Question: Write a single sentence explaining what this figure depicts.
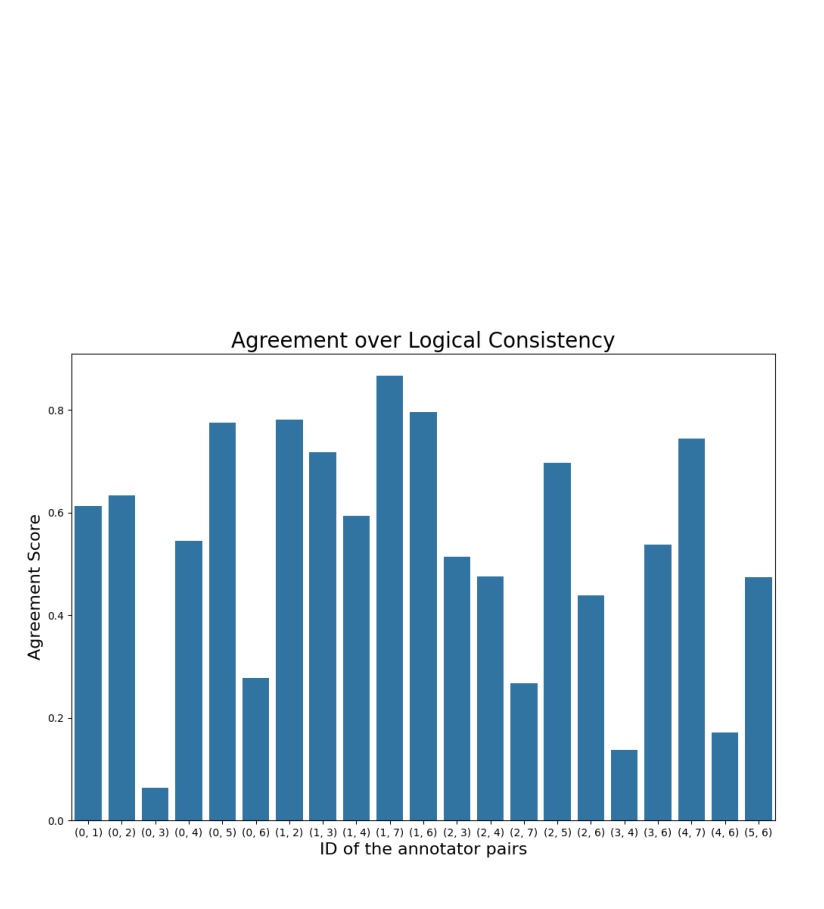
Answer: Annotator Agreement over the Logical Consistency of a given reasoning step